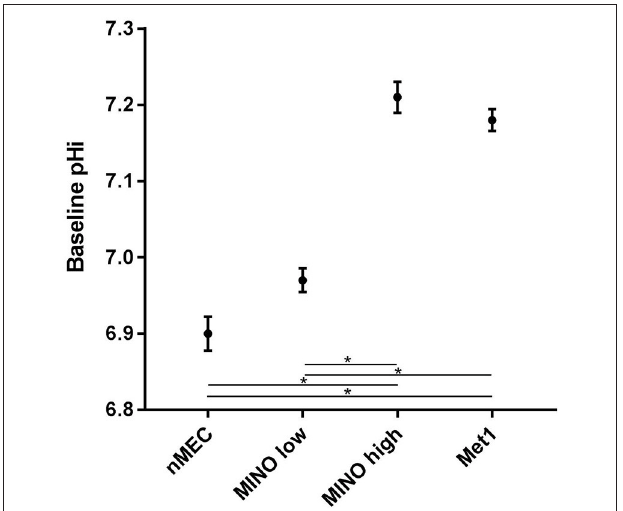
FIGURE 5 | Metabolic heterogeneity exists within the MINO, some cells are more cancer-like in their metabolism while others retain a more normal-like metabolism. Mean baseline pH i and standard error are shown for Met1 [7.18 ± 0.01; n = 8 coverslips (145 cells)], nMEC [6.9 ± 0.02; n = 9 coverslips (120 cells)], MINO high [7.21 ± 0.02; n = 4 coverslips (9 cells)] and MINO low [6.97 ± 0.02; n = 7 coverslips (59 cells)]. Means were calculated from the first 200s of measurement. Analysis of variance for repeated measures demonstrated differences in baseline pH i . The Student-Newman-Keuls multiple comparison test was used post-hoc to determine which groups were different with P < 0.05 chosen as indicative of significant differences. * P <